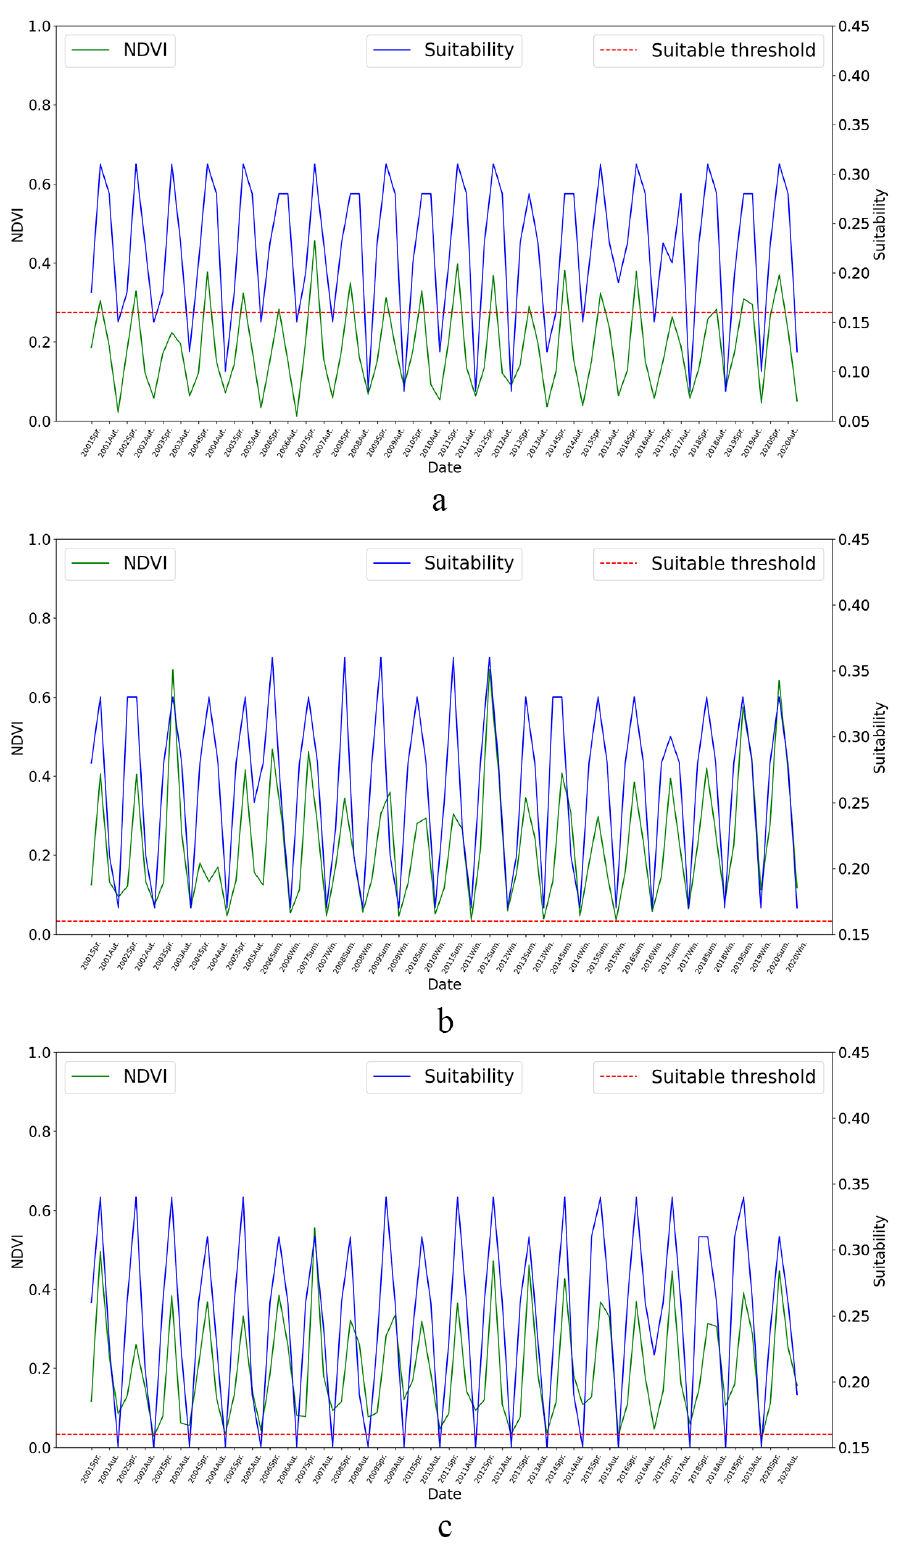
Figure 8. Time-series suitability comparisons with NDVI of ( a ) Iwamizawa, ( b ) Shenyang, ( c ) Taehongdan.